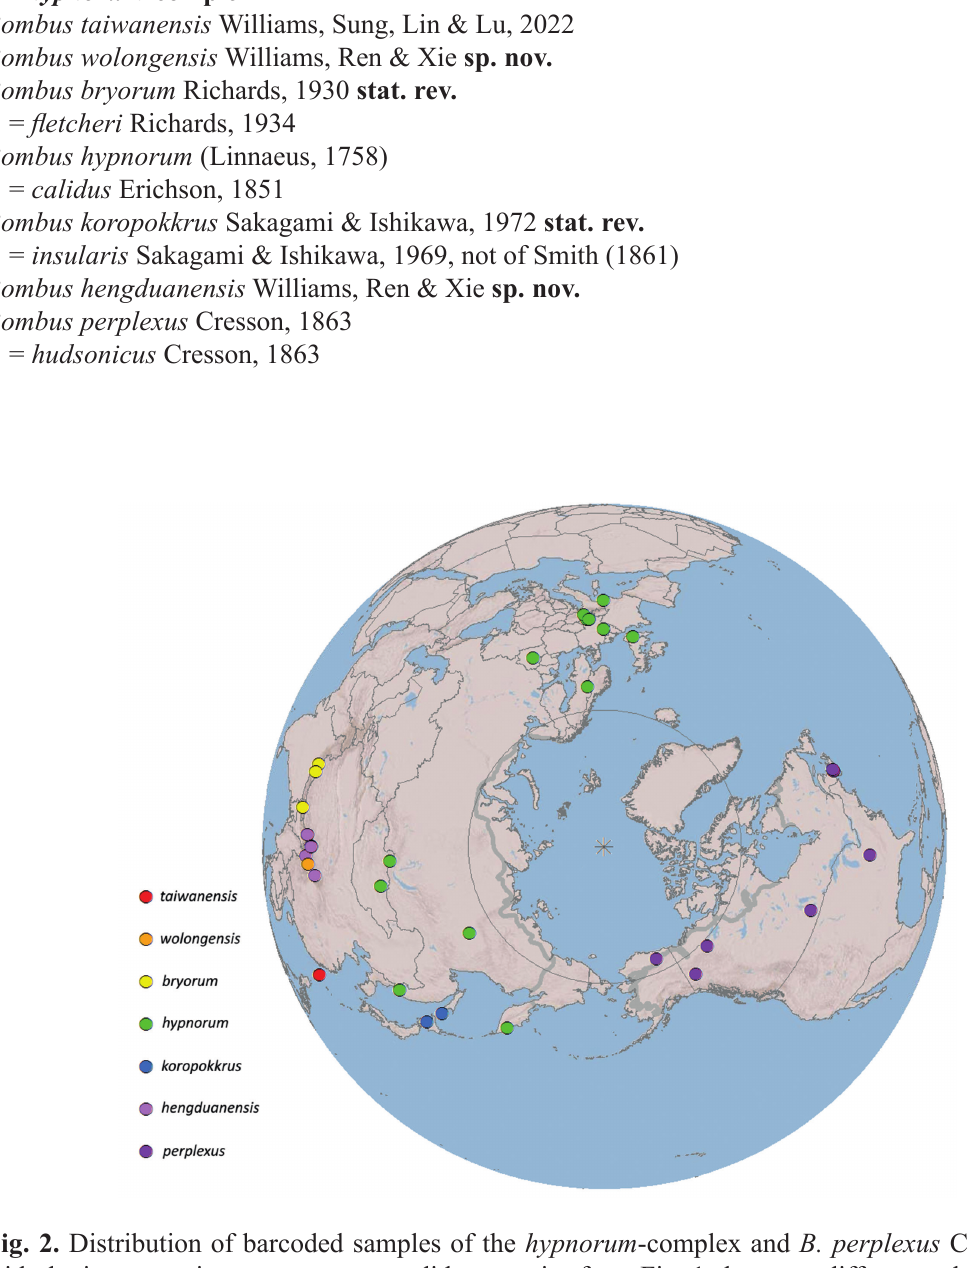
Fig. 2. Distribution of barcoded samples of the hypnorum -complex and B. perplexus Cresson, 1863, with the interpretations as separate candidate species from Fig. 1 shown as different coloured spots as per the colour key on the left. Relief map with hill shading, polar projection (north pole shown as a star), the international boundaries and the Arctic Circle are shown as narrow grey lines, and the northern tree line shown as a broad grey line. Image created in ArcGIS using World_Shaded_Relief basemap (© 2014